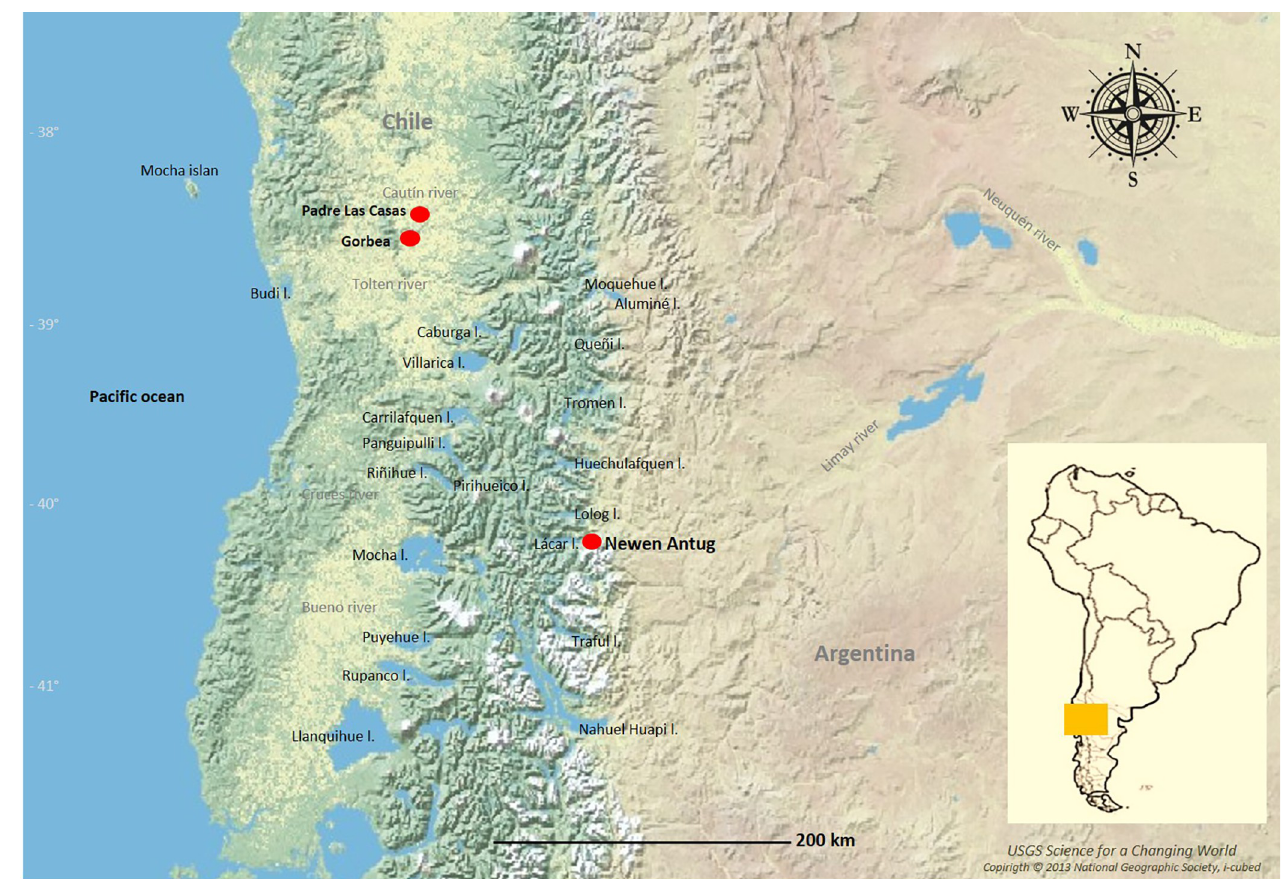
Fig 1. Main bodies of water mentioned and archaeological sites in